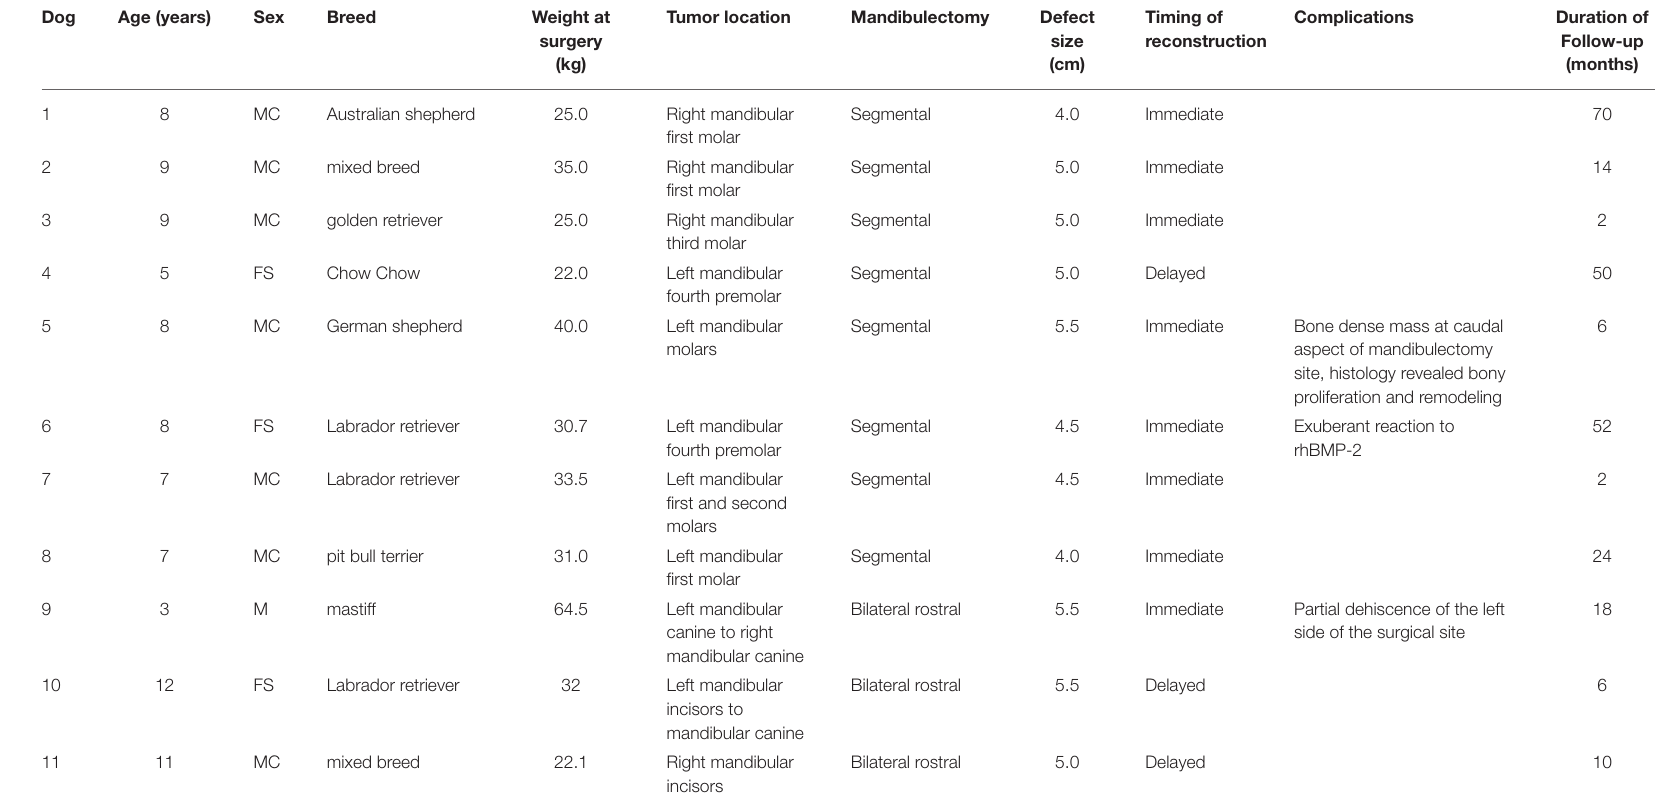
TABLE 1 | Summary data for 11 dogs that received segmental and bilateral rostral mandibulectomy for CAA and reconstruction using a regenerative approach.